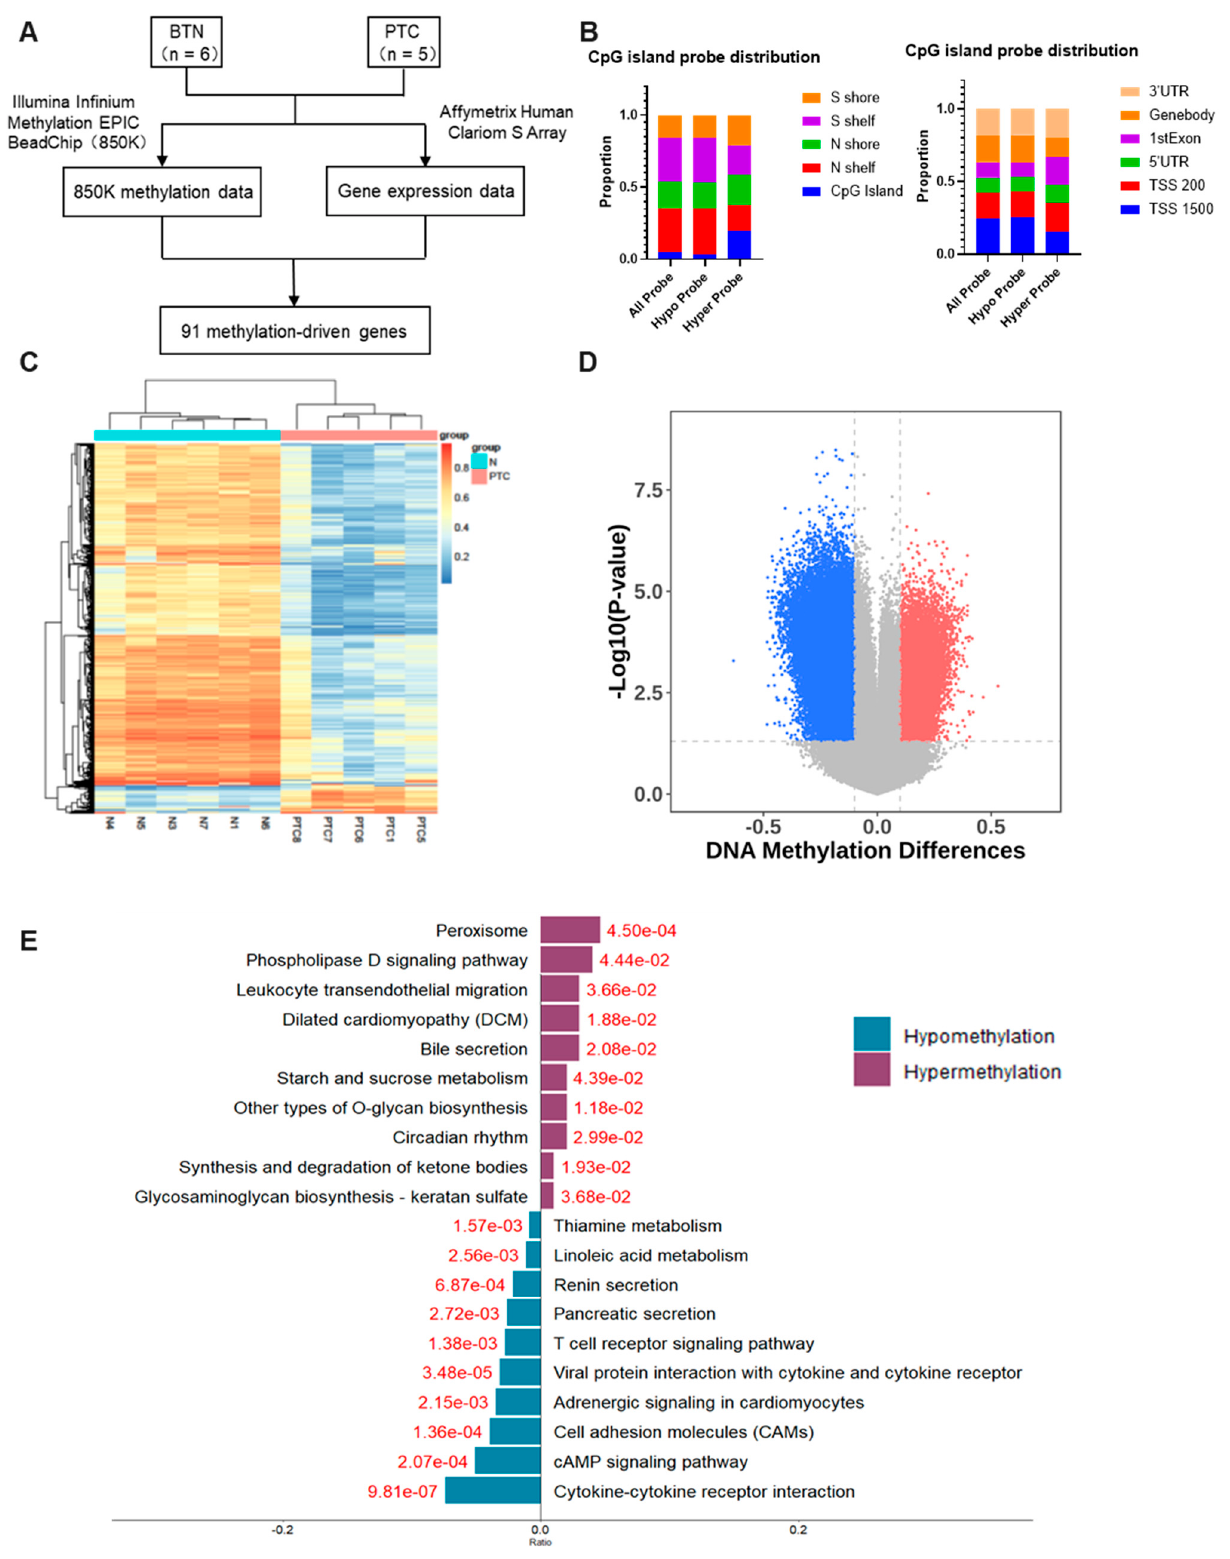
Figure 1. The whole-genome DNA methylation profile of papillary thyroid carcinoma. ( A ) The schematic flow chart of selection of methylation-driven genes. ( B ) Differential methylation regions distri- bution according to CpG island annotation, and according to gene annotation. ( C , D ) DNA methylation differences between thyroid nodules and PTC are shown by a heatmap ( C ) and a volcano plot ( D ). ( E ) The top 10 KEGG enrichment analysis results of genes with significant methylation